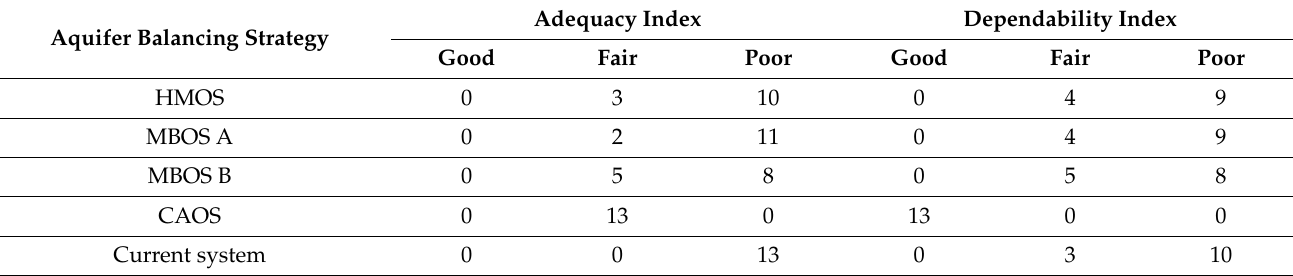
Table 5. Number of reservoirs in the Nekouabad surface water distribution system in each category of adequacy and dependability indices of water distribution after the application of the strategies due to the 30% drought